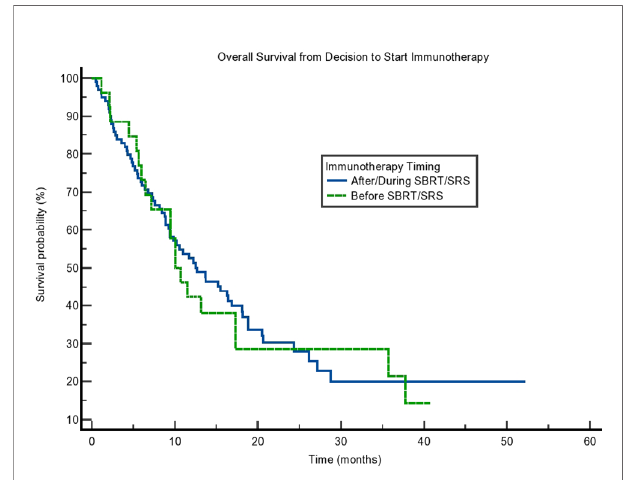
FIGURE 1 | Kaplan – Meier curve showing overall survival (OS) from the end of stereotactic body radiotherapy (SBRT)/stereotactic radiosurgery (SRS).